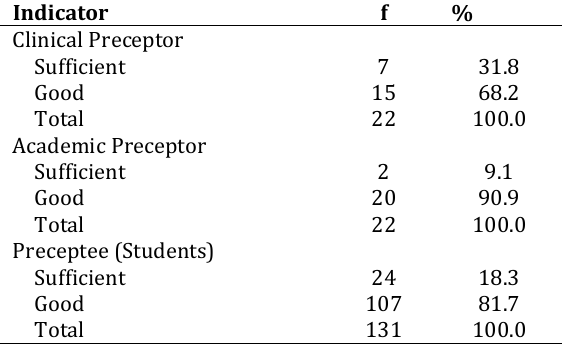
Table 1. Antecedent Evaluation (n =